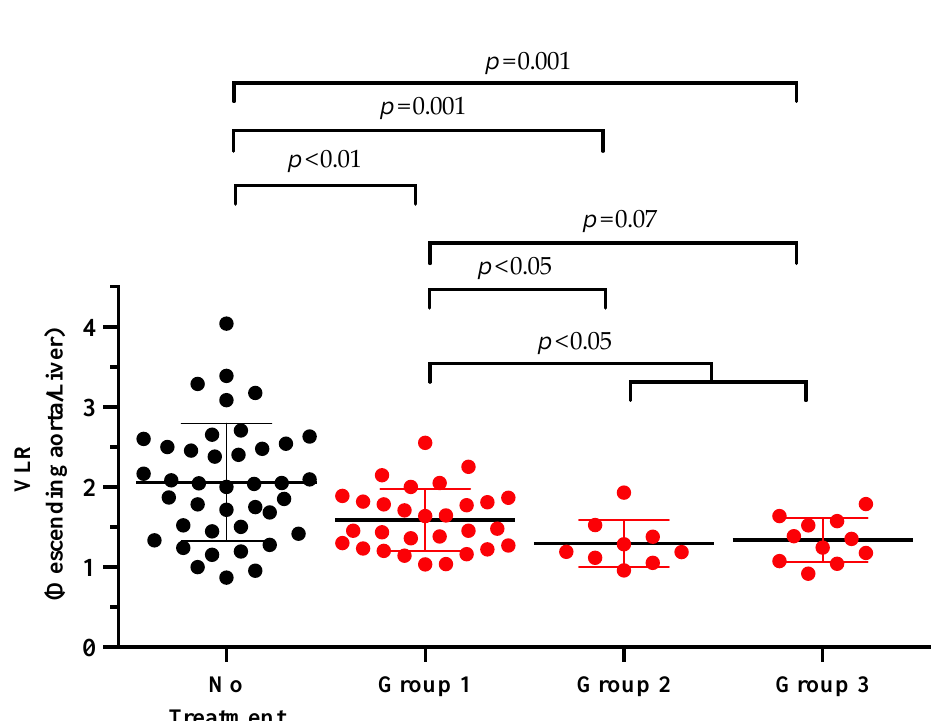
Figure 2. Quantitative assessment of the most profoundly affected vessel segment (descending aorta). Comparison of patients with no treatment vs. subjects receiving prednisone alone (Group 1), individu- als with methotrexate intake in combination with prednisone (Group 2) or other immunomodulatory drugs (mycophenolate mofetil, azathioprine, rituximab, and leflunomide) in combination with pred- nisone (Group 3) at the time of PET/CT. Uptake in vessel walls decreased with the additional intake of immunomodulatory